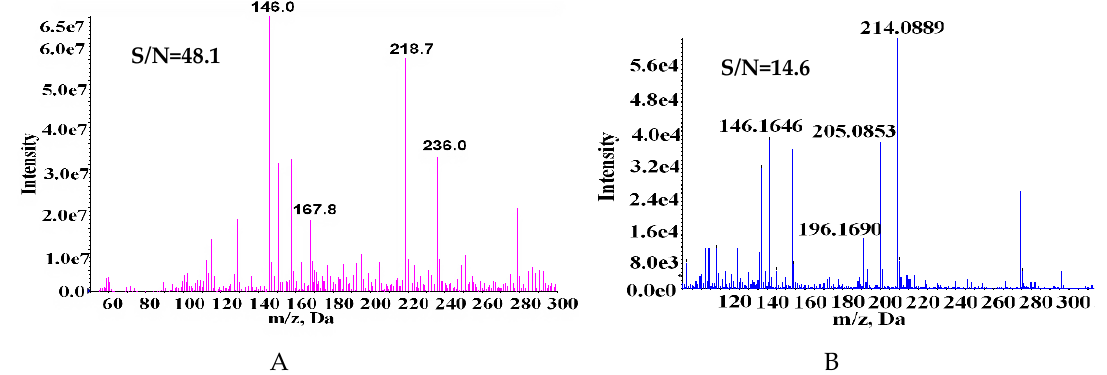
Figure 1. The full scan mass spectra of 10 mg/L SPD by ( A ) DART-MS; ( B ) UHPLC-ESI-QTOF method. S/N was given to ion at m/z 146.